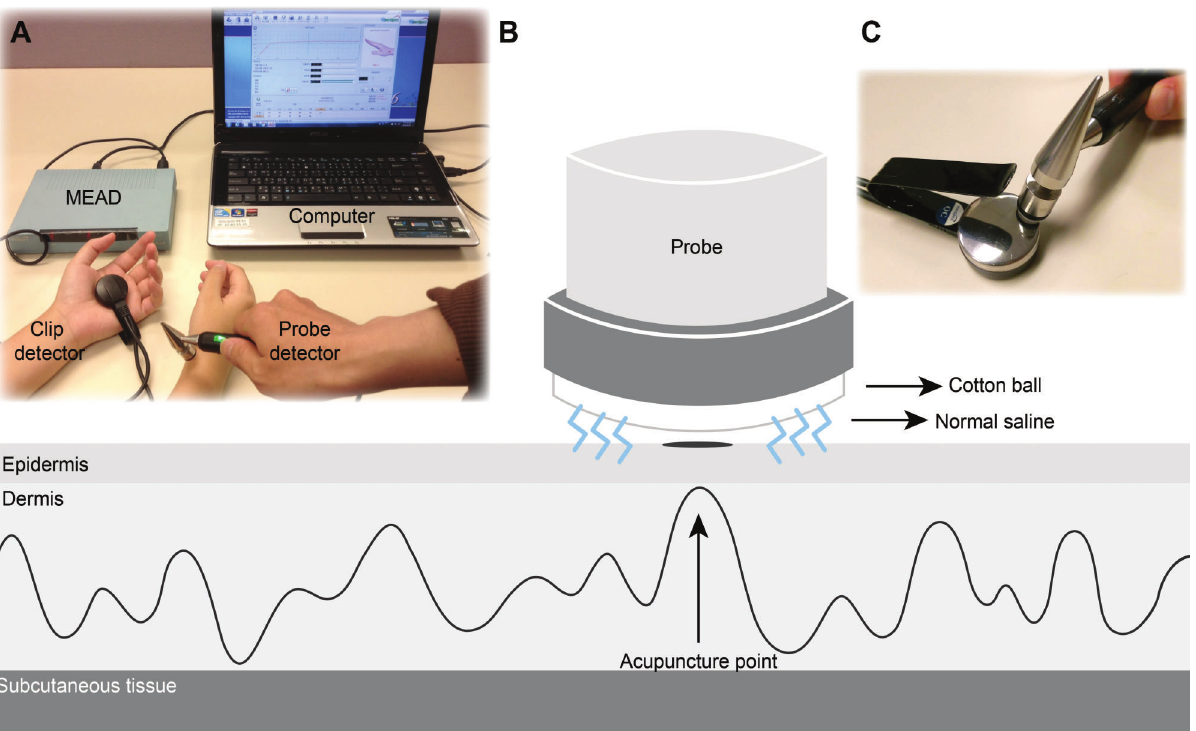
Figure 1 - Diagram of the schematic meridian energy analysis device (MEAD). Figures 1A and 1B: The experimental setup of the MEAD Instrument and electric current measurement around the acupoints. Figure 1C: A simple way to confirm the accuracy of MEAD using automatic digital calibration